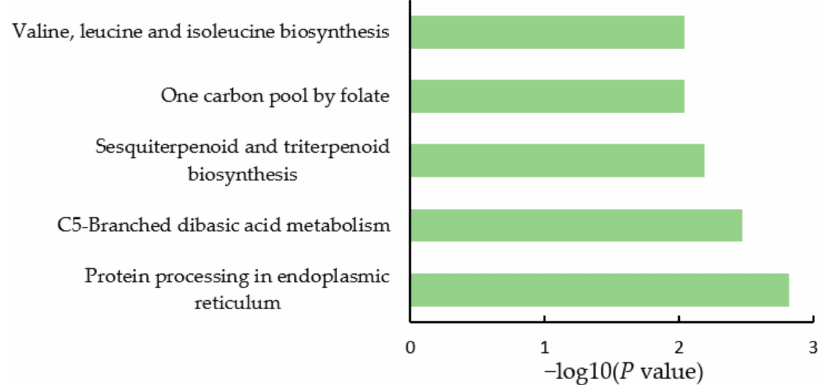
Figure 4. KEGG pathway of the DEPs in soybean nodule tissue after nitrogen supply.